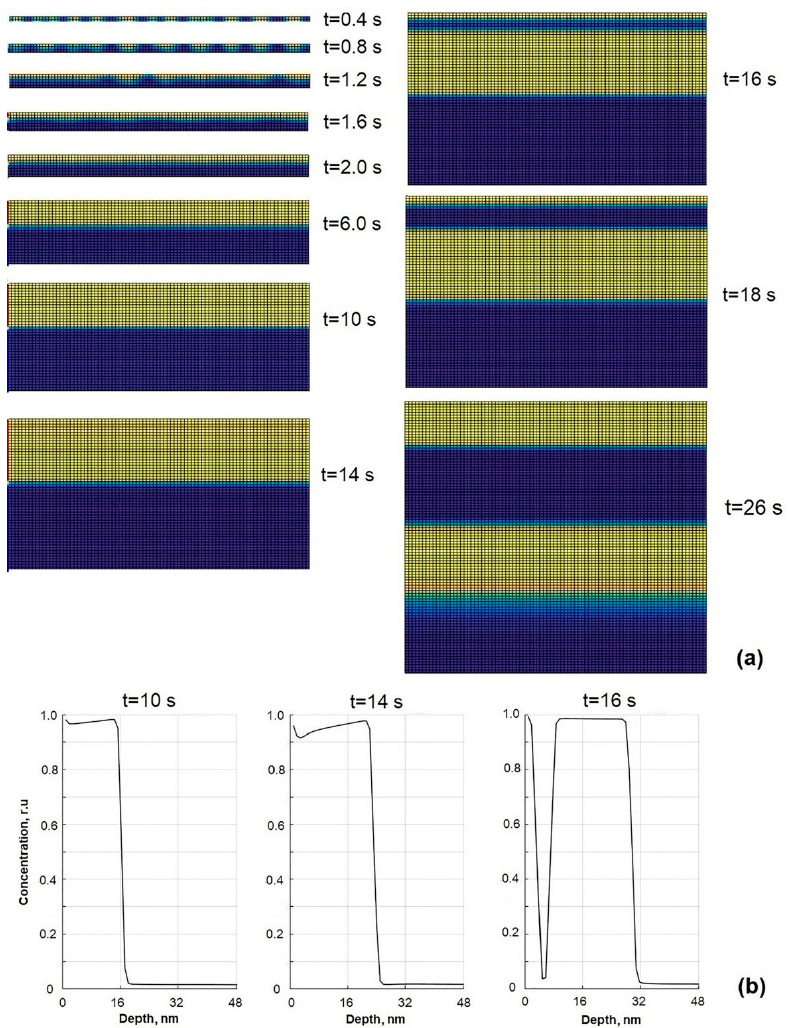
Figure 2. The dynamics of binary thin film phase structure in the early growth stages: ( a ) cross-sectional views and ( b ) depth profiles of component A (yellow) at different moments of time showing the splitting of first layer into two new layers.